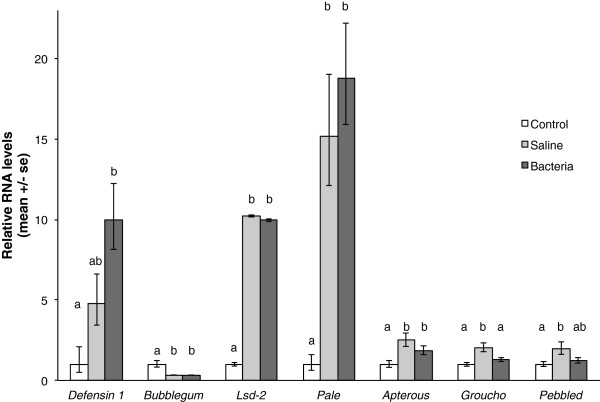
Quantitative real-time PCR validation of expression patterns of candidate genes. Expression levels of seven candidate genes (relative to actin) were analysed in a third biological replicate using quantitative real-time PCR. Mean expression levels for each treatment group are normalized to expression in the control treatment group, for graphical representation. Significant differences in expression levels across the three treatment groups were determined using an ANOVA with treatment as a variable, followed by post-hoc Tukey HSD pairwise comparisons. Different letters denote significant differences in expression (p<0.05). Nine, eight, and ten individual bees were used for the control, saline-injected, and bacteria-injected treatment groups, respectively.